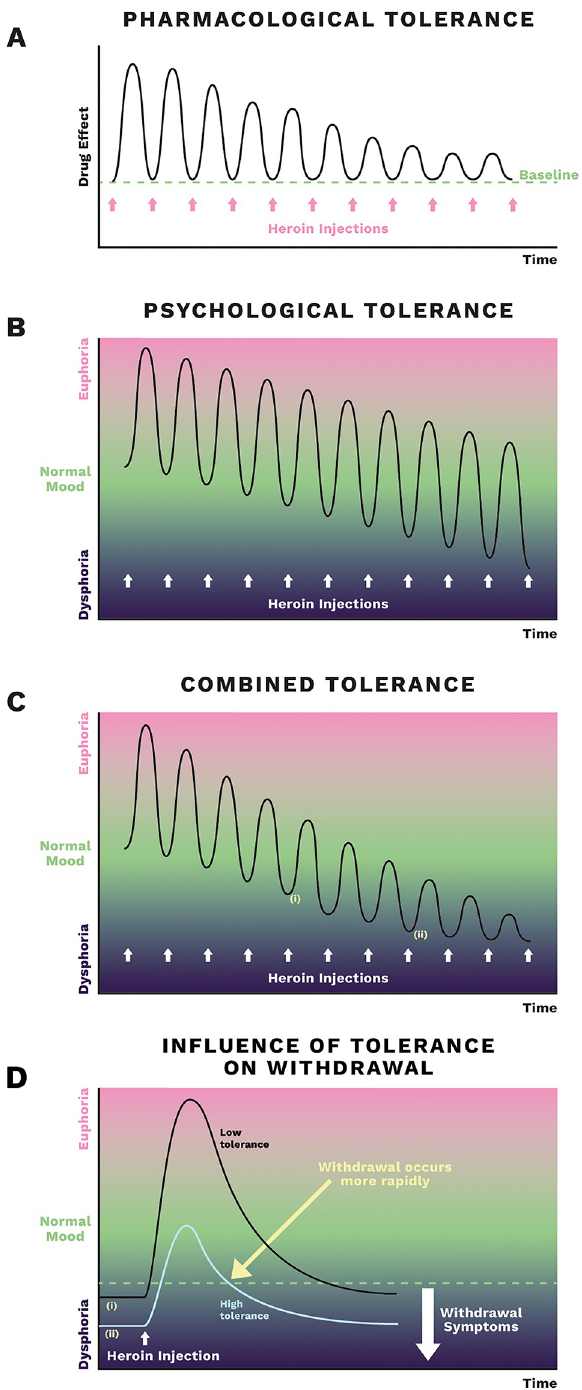
Fig 1. Tolerance development. A schematic showing the amplitude of response evoked by a repeated dose of heroin. (A) In the development of pharmacological tolerance, opioid receptors become progressively less responsive and this results in a reduced response amplitude with no change in baseline. (B) In psychological tolerance there is no change in the amplitude of the response evoked by the drug injection but between injections mood is depressed when the effect of the drug wears off. As the baseline mood falls progressively with drug use then the peak height of the drug effect is also lowered. Adapted from reference 11. (C) If both pharmacological and psychological tolerance are produced then not only does the baseline mood fall between drug doses but the amplitude of the response evoked by the drug injection will also decrease. (D) Comparison of the responses to the same dose of heroin under circumstances